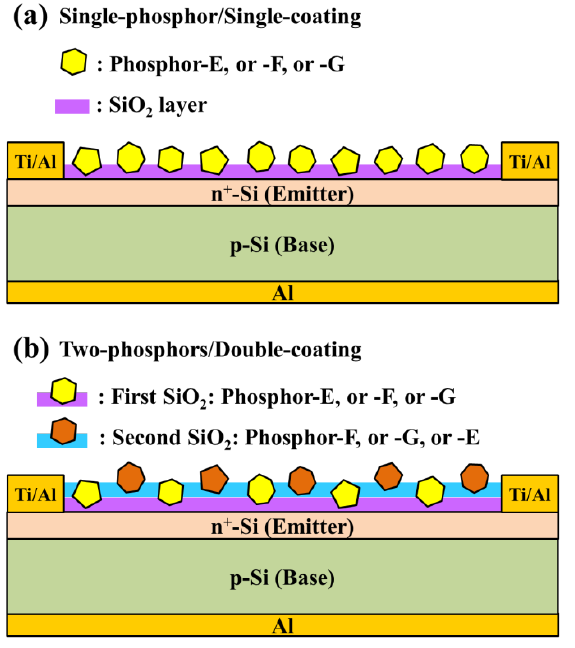
Figure 1. Schematic diagram of the sample with ( a ) single coating of SiO 2 containing a single phosphor, and ( b ) a double coating of SiO 2 containing two different phosphors.